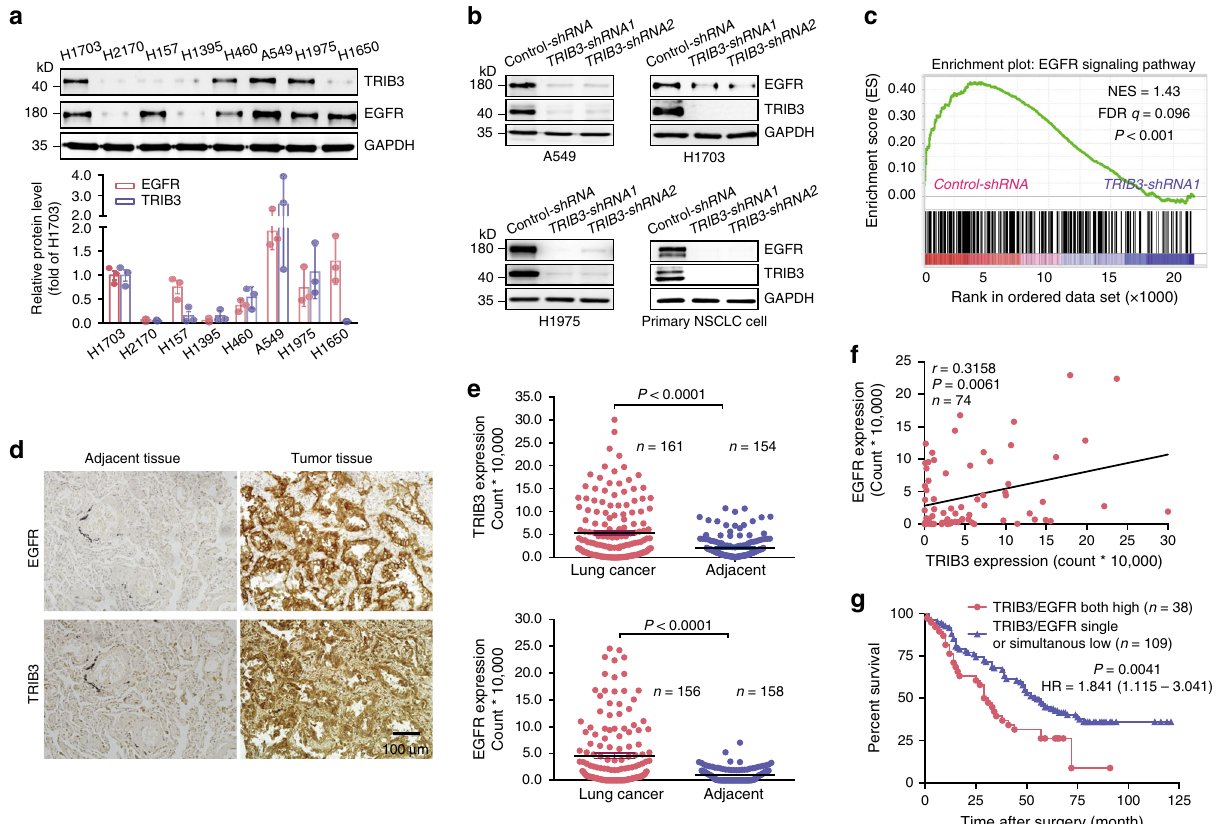
Fig. 1 TRIB3 expression positively correlates with EGFR in NSCLC. a Immune-blotting (IB) analyses of TRIB3 and EGFR expression in the indicated NSCLC cell lines. The western blots were quanti fi ed by densitometry and calculated relative to GAPDH. The data were normalized as fold of H1703 group and presented as means ± SEMs of three independent biological studies. b IB analyses of TRIB3 and EGFR expression in the indicated NSCLC cells stably expressed control-shRNA or TRIB3-shRNAs . Data are representative immunoblots of three independent assays. c GSEA analysis of the “ EGFR signaling ” gene modules in A549 cells stably expressed control-shRNA or TRIB3-shRNA1 . FDR q false discovery rate q value, NES normalized enrichment score. d Representatives of immunohistochemical staining of TRIB3 ( n = 161 of lung cancer tissues; n = 154 of adjacent tissues) or EGFR ( n = 156 of lung cancer tissues; n = 158 of adjacent tissues). e Quantitative analysis of EGFR and TRIB3 expression levels in paired clinical samples. Data are presented as means ± SEM. Statistical signi fi cance was determined by two-tailed Student ’ s t test. f Correlation between TRIB3 and EGFR expression in lung cancer patients at T2 or higher TNM stage. Each point represents the value from one patient. The P value is measured by Pearson ’ s rank correlation test. g Kaplan – Meier plot of overall survival of patients with lung cancer strati fi ed by TRIB3 and EGFR coexpression level. Patients were divided into two groups: high TRIB3 – EGFR expressions vs. single or simultaneous low TRIB3 – EGFR expression. Statistical difference was determined by two-sided log-rank test. Source data are provided as a Source Data fi EGFR, either WT-EGFR or its activating and resistant mutants.